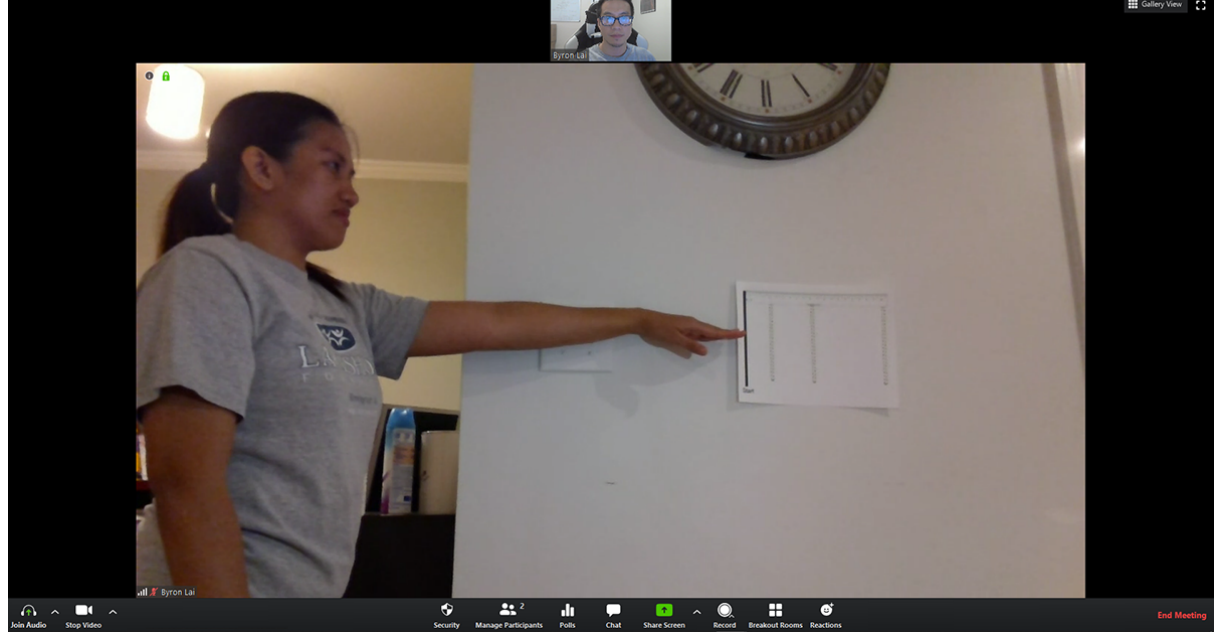
Figure 4. An example of the videoconference view for the starting position of the functional reach task of the Berg Balance